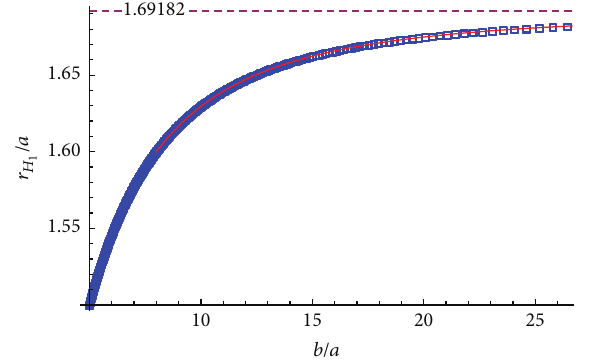
Figure 2: The numerical points of (7) are plotted in blue color, and the fitting curve of (8) is plotted in red color. The relative error is less than 4 × 10 −5